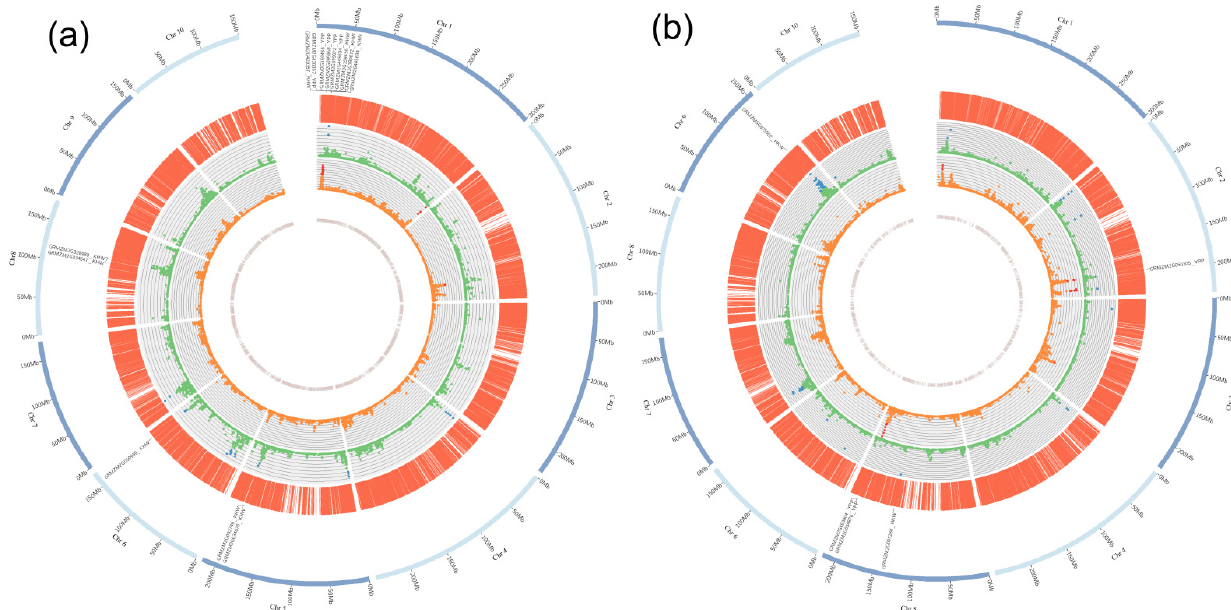
Figure 6. Co-localization of significant SNPs and DEGs identified candidate genes for hybrid perfor- mance. ( a ) Co-localization of significant SNPs detected in the Chang7-2 TC population and the DEGs between ZD958 and its parental lines (Zheng58 and Chang7-2). The five circles, from inner to outer, indicate the location of common DEGs identified between ZD958 and each of its parental lines, the MTA results for YPP in the Chang7-2 TC population (red points indicate significant SNPs), the MTA results for HKW in the Chang7-2 TC population (blue points indicate significant SNPs), SNP density heatmap and the candidate genes in the surrounding regions of significant SNPs, and maize chromo- somes. ( b ) Co-localization of significant SNPs detected in the PH6WC TC population and the DEGs identified between XY335 and its parental lines (PH6WC and PH4CV). The five circles, from inner to outer, indicate the location of common DEGs between XY958 and each of its parental lines, the MTA results for YPP in the PH6WC TC population (red points indicate significant SNPs), the MTA results for HK in the PH6WC TC population (blue points indicate significant SNPs), SNP density heatmap and the candidate genes in the surrounding regions of significant SNPs, and maize